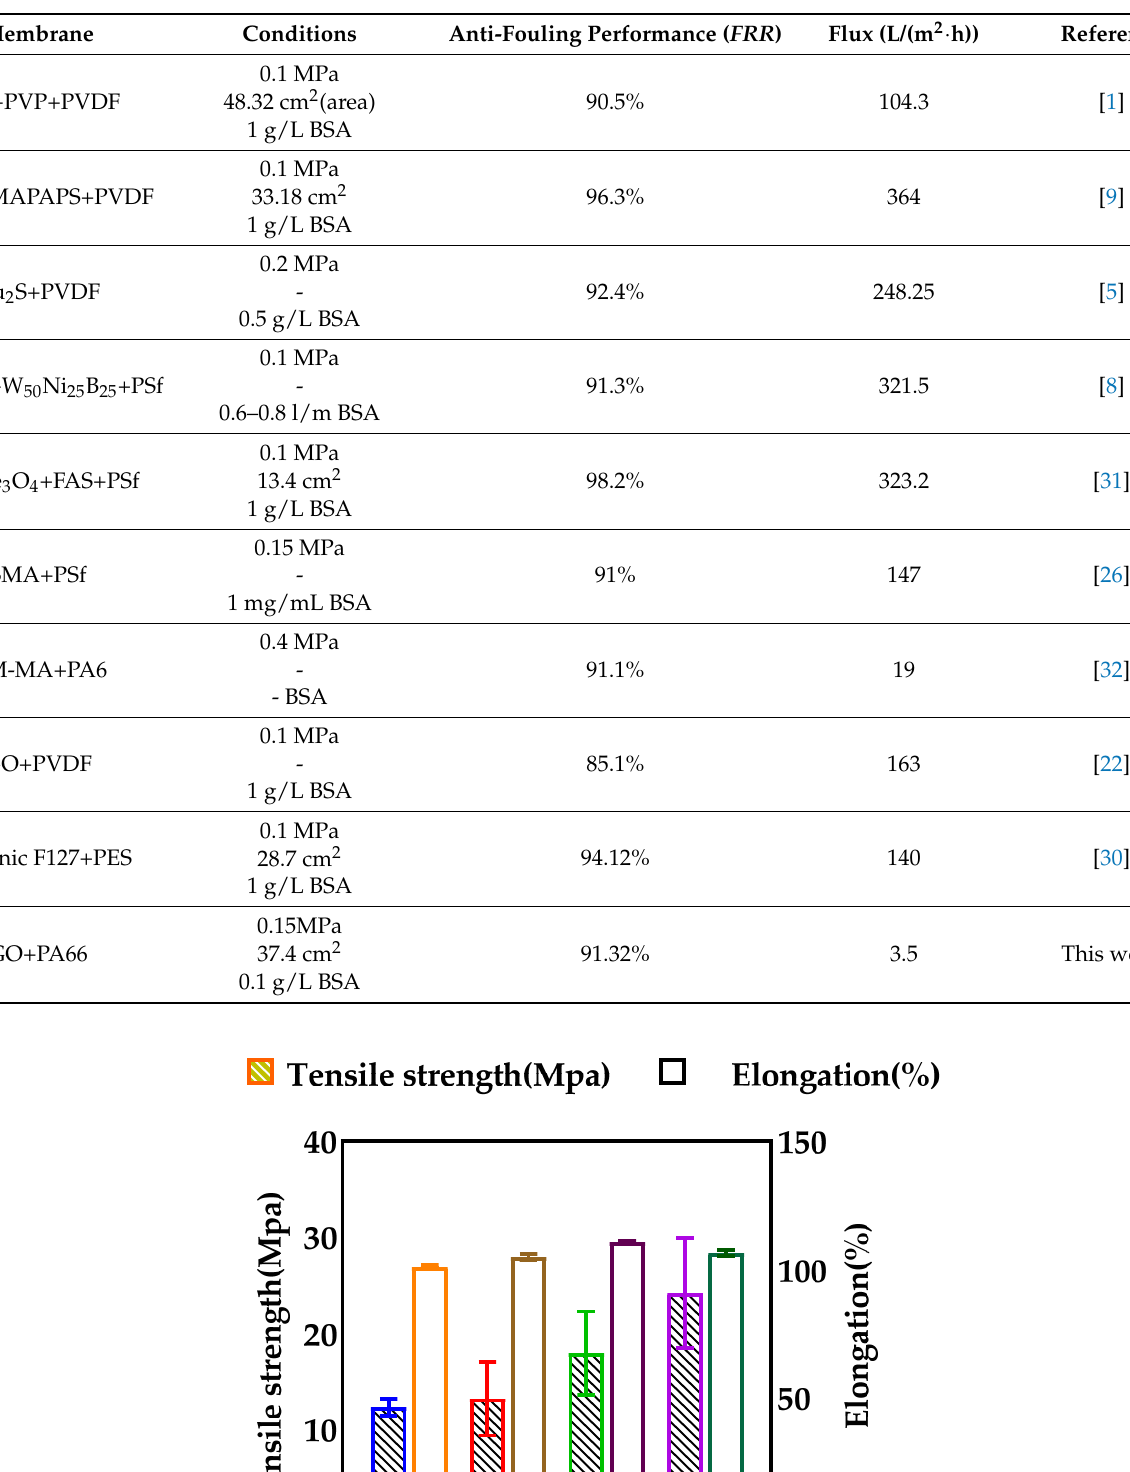
Table 3. Comparison of the reported UF membranes with the UF membrane prepared in this study.